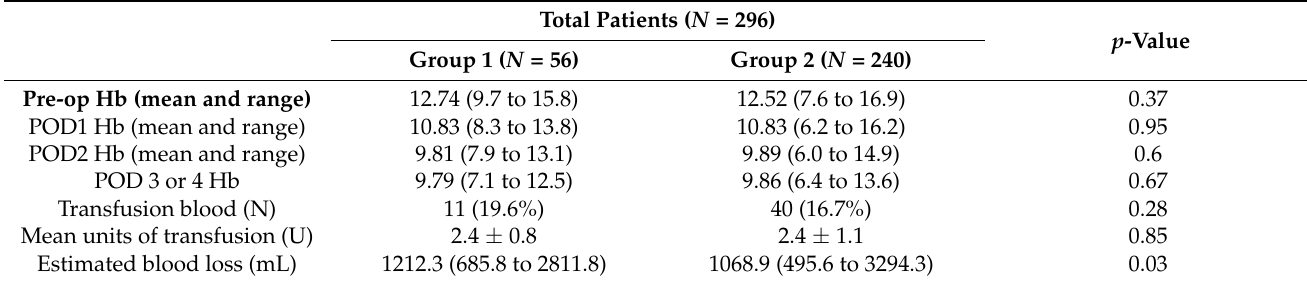
Table 2. Bleeding risk between the two groups of patients.